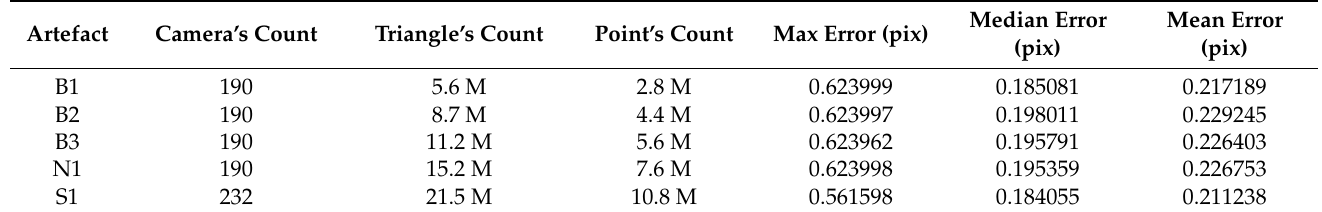
Table 3. Alignment settings and reprojection errors calculated for all datasets with RC